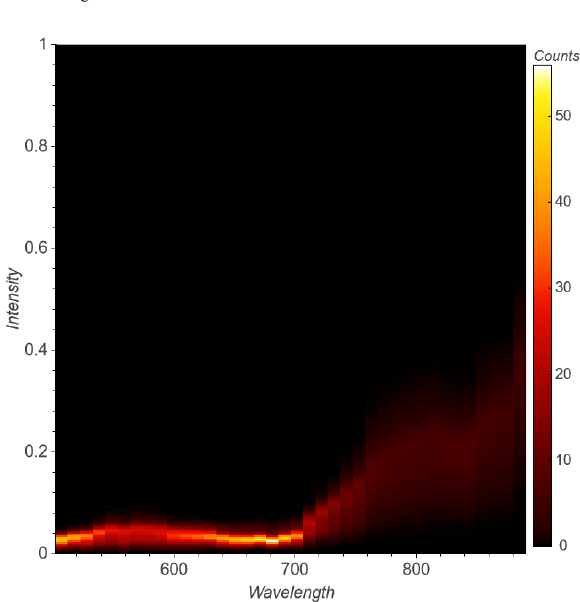
Figure 17. Visualisation of the histogram. The histogram tool returns an image of the histogram, the values of the histogram and the bin